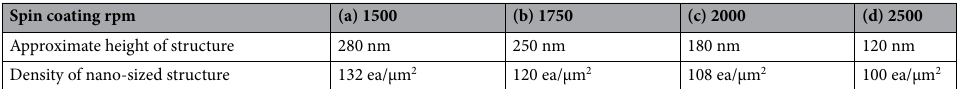
Table 1. Height and density of the nano-sized structures of PMMA as a function of the spin coating speed.